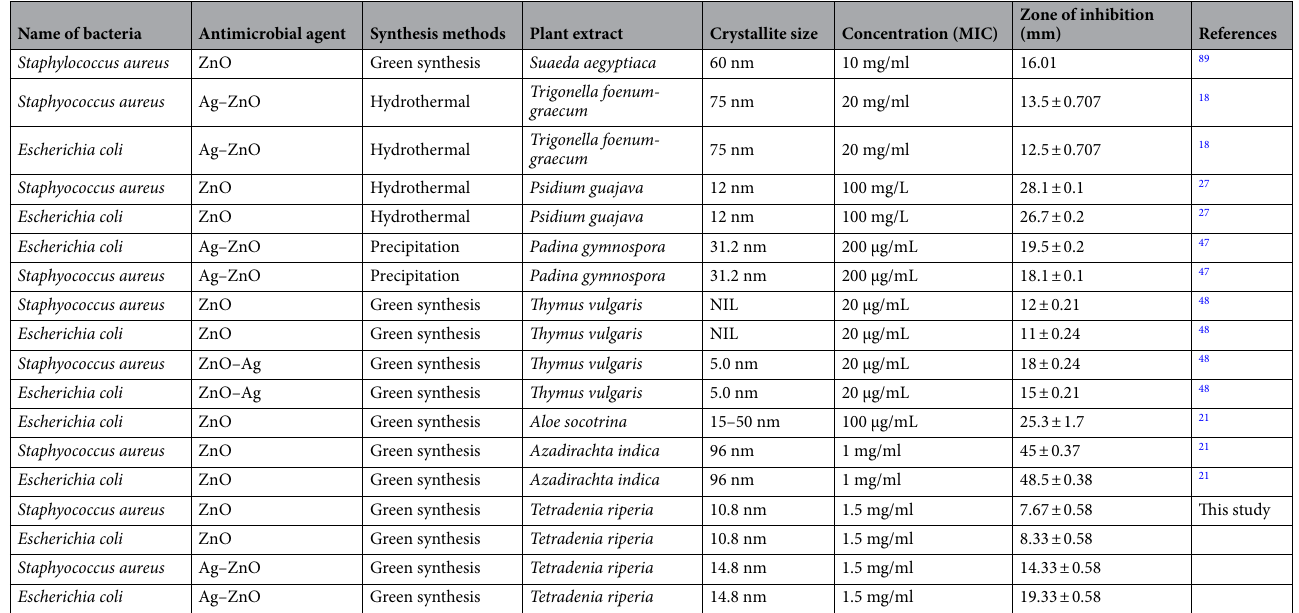
Table 2. Comparison of antimicrobial activity of ZnO and Ag–ZnO from this study with other published